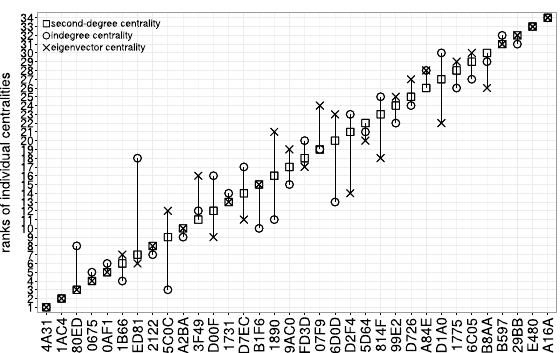
Figure 5. Ranked individual influence of bats of colony GB2 in year 2008. Thex-axis displays the last four digits of a bat’s uniqueidentification number. The y-axis displays the rank according to thesecond degree centrality (square symbols) in increasing rank order(rank 1—highest centrality). For each bat we additionally plot itsrank when importance is quantified as in-degree (circle symbols) andeigenvector centrality (cross symbols). Overlap of the three symbolsindicates that the given individual has the same rank, regardless ofthe centrality measure used. For the individual centrality valuessee Figure